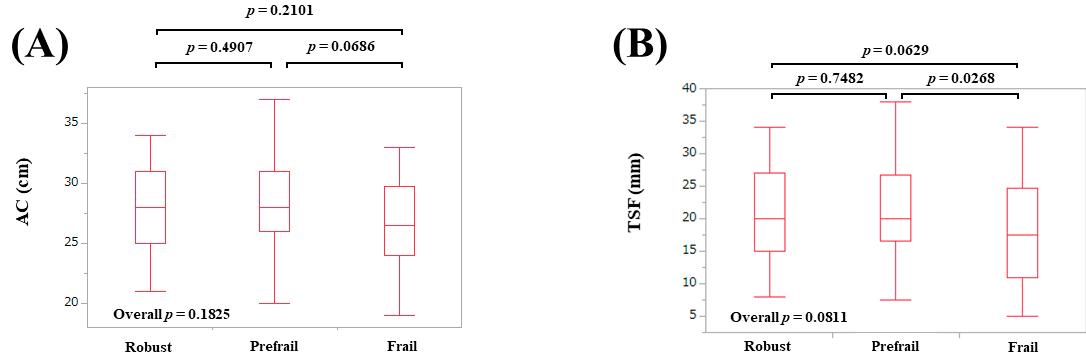
Figure 3. Anthropometry measurements according to frailty status in female participants. ( A ) Arm circumference; ( B ) Triceps skinfold thickness.